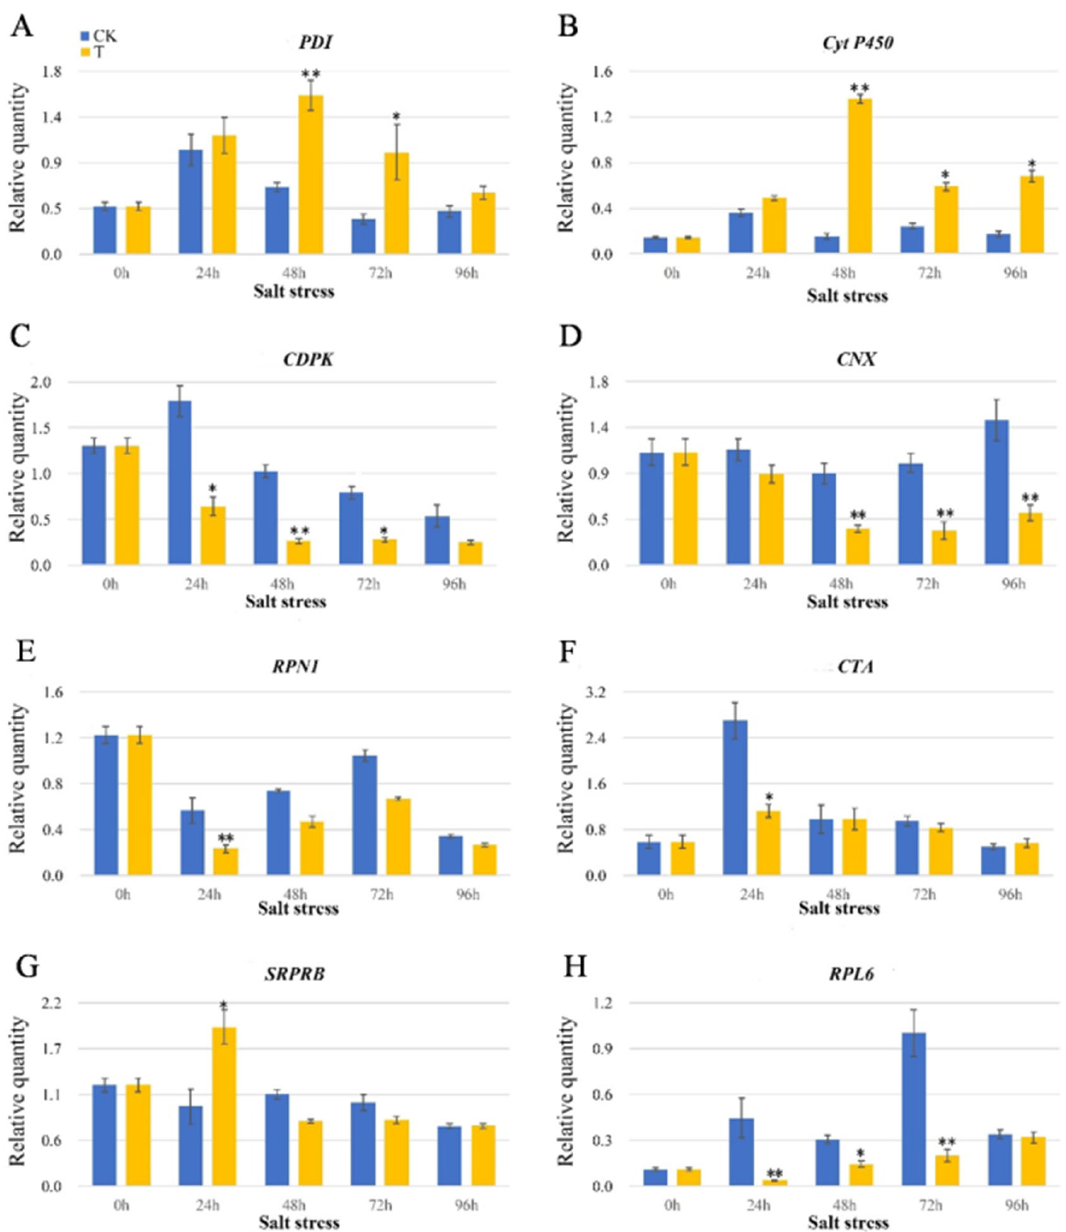
Figure 5. Transcript expression patterns of eight DAP genes in wheat ER under salt stress via RT ‐ qPCR. ( A ) Protein disulfide ‐ isomerase; ( B ) cytochrome P450; ( C ) calcium ‐ dependent protein kinase; ( D ) calnexin homolog; ( E ) dolichyl ‐ diphosphooligosaccharide ‐ protein glycosyltransferase subunit 1 (RPN1); ( F ) calcium ‐ transporting ATPase; ( G ) signal recognition particle receptor subunit beta (SRPRB); ( H ) 50S ribosomal protein L6. Statistically significant differences were calculated based on an independent Student’s t ‐ test: * p < 0.05; ** p < 0.01.